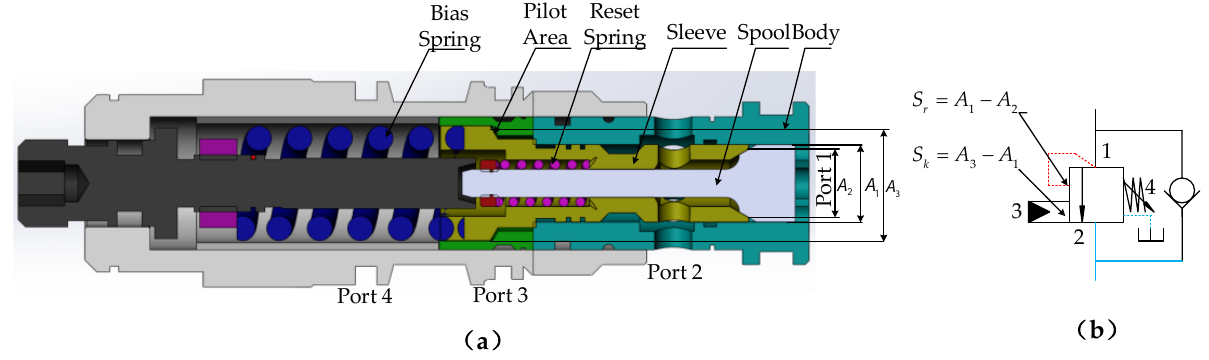
Figure 1. ( a ) Cross-section of counterbalance valve (CBV), ( b ) function symbol of CBV.